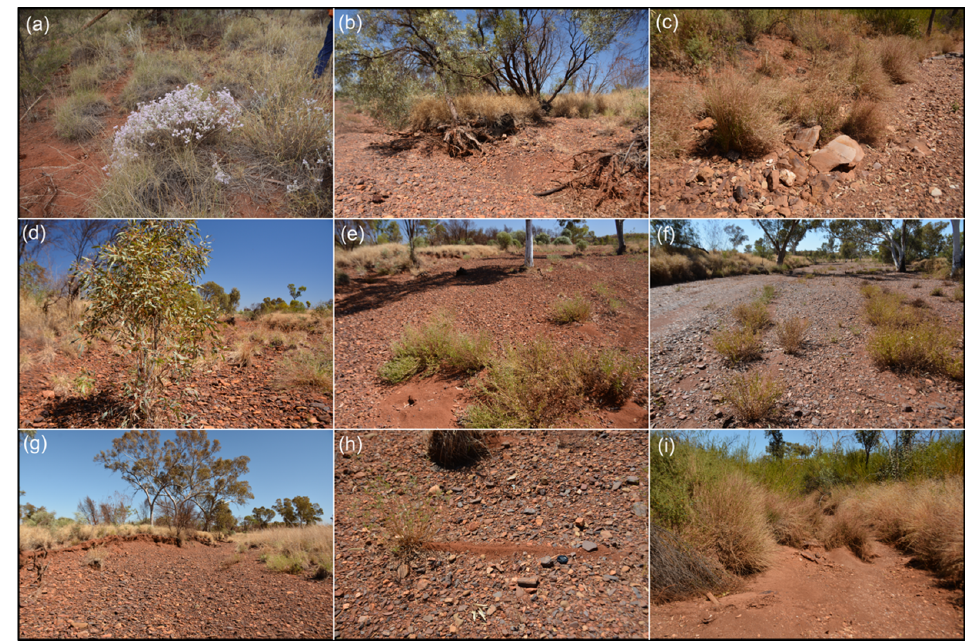
Figure 1. Vegetation found within the headwater channels in the Pilbara region: ( a ) cotton bush ( Ptilotus obovatus ) and hard spinifex ( Triodia lanigera ), ( b ) LWD in a cobble substrate, ( c ) soft spinifex and buffel grass in a cobble bed, ( d ) young tree, ( e ) small shrubs and fine sediment in a cobble channel, ( f ) vegetation in a cobble substrate, ( g ) eucalyptus tree surrounded by soft spinifex, ( h ) narrow ridge-bar, ( i ) highly vegetated sand-bed channel.